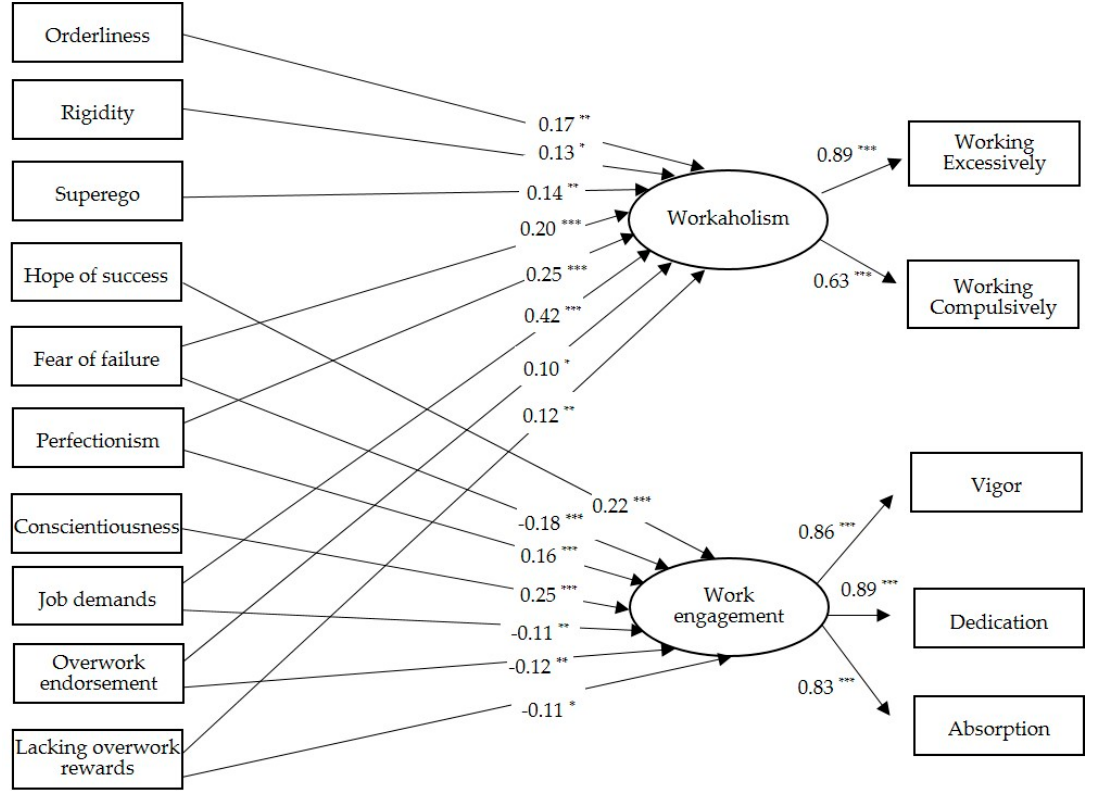
Figure 1. Structural equation results for the hypothesized model. Note. * p < 0.05; ** p < 0.01; *** p < 0.001.